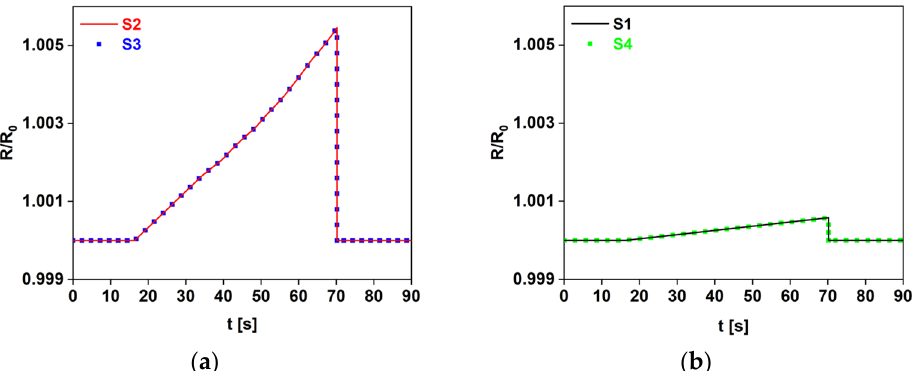
Figure 14. Comparison between the simulation of the sensors perpendicular ( a ) and parallel ( b ) to the load.